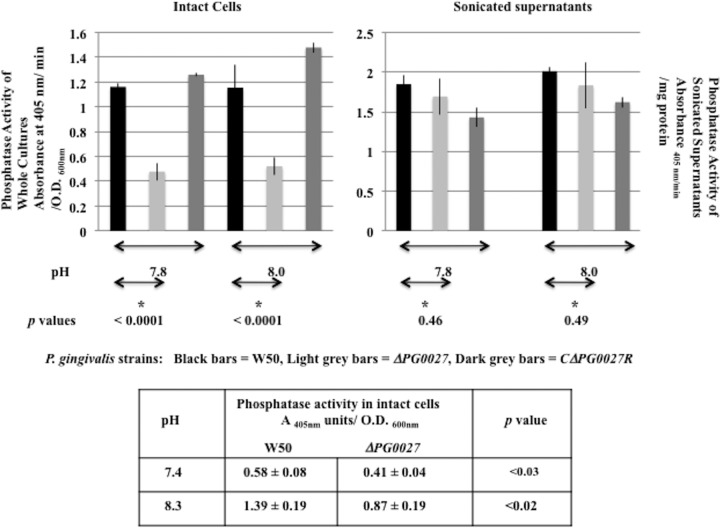
Phosphatase activities of intact cells and sonicated supernatants of P. gingivalis strains. Phosphatase activities were measured with 4-nitro-phenylphosphate as the substrate as described in Materials and Methods and expressed as units based on the change in the A405/OD600 ratio of intact cells and as units based on the change in the A405 per milligram of protein in sonicated supernatants. Activities were measured at pHs 7.4, 7.8, 8.0, and 8.3 with either continuous or discontinuous assays. The activities obtained at pHs 7.8 and 8.0 are shown as histograms. Black bars, P. gingivalis W50; light gray bars, ΔPG0027; dark gray bars, CΔPG0027R. P values (Student's t test) are indicated below the pairs. The activities obtained at pHs 7.4 and 8.3 and the P values determined from the data are shown at the bottom.